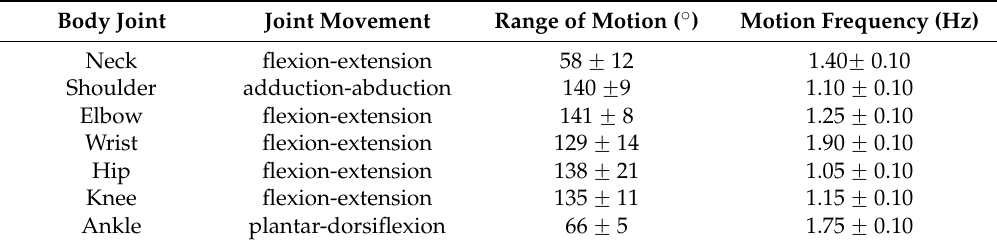
Table 2. Body joints, body joint movements, range of motion [31] and frequency of